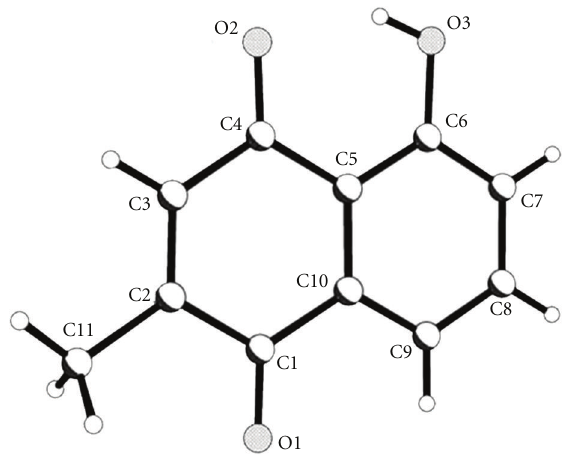
Scheme 1: Crystal structure of plumbagin.